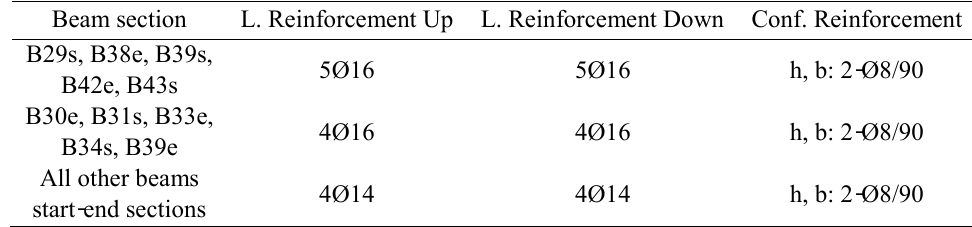
Longitudinal and confinement reinforcement of beam end-sections (s: start, e: end). Beam